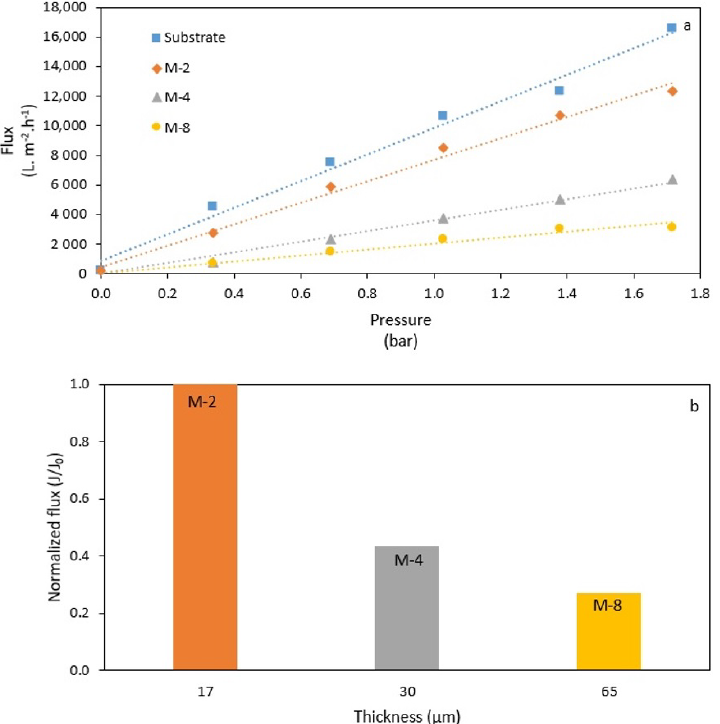
Figure 10. ( a ) Clean water flux as a function of pressure for porous substrate, M-2, M-4, and M-8 membranes, and ( b ) Normalized water flux as a function of membrane thickness.